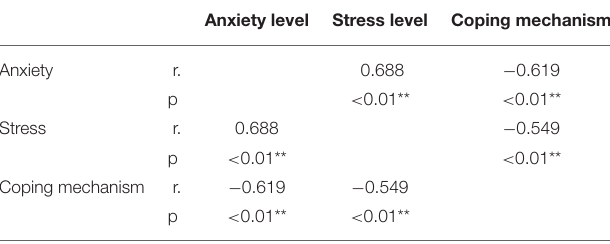
TABLE 7 | Correlations between studied variables.